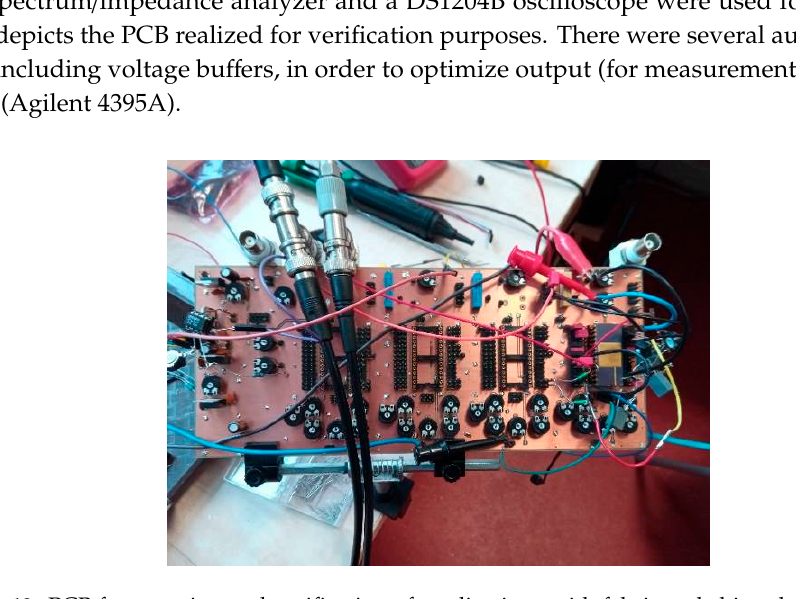
Figure 13. PCB for experimental verification of applications with fabricated chips shown in case of using only one IC package as discussed in the paper (implementation of the designed